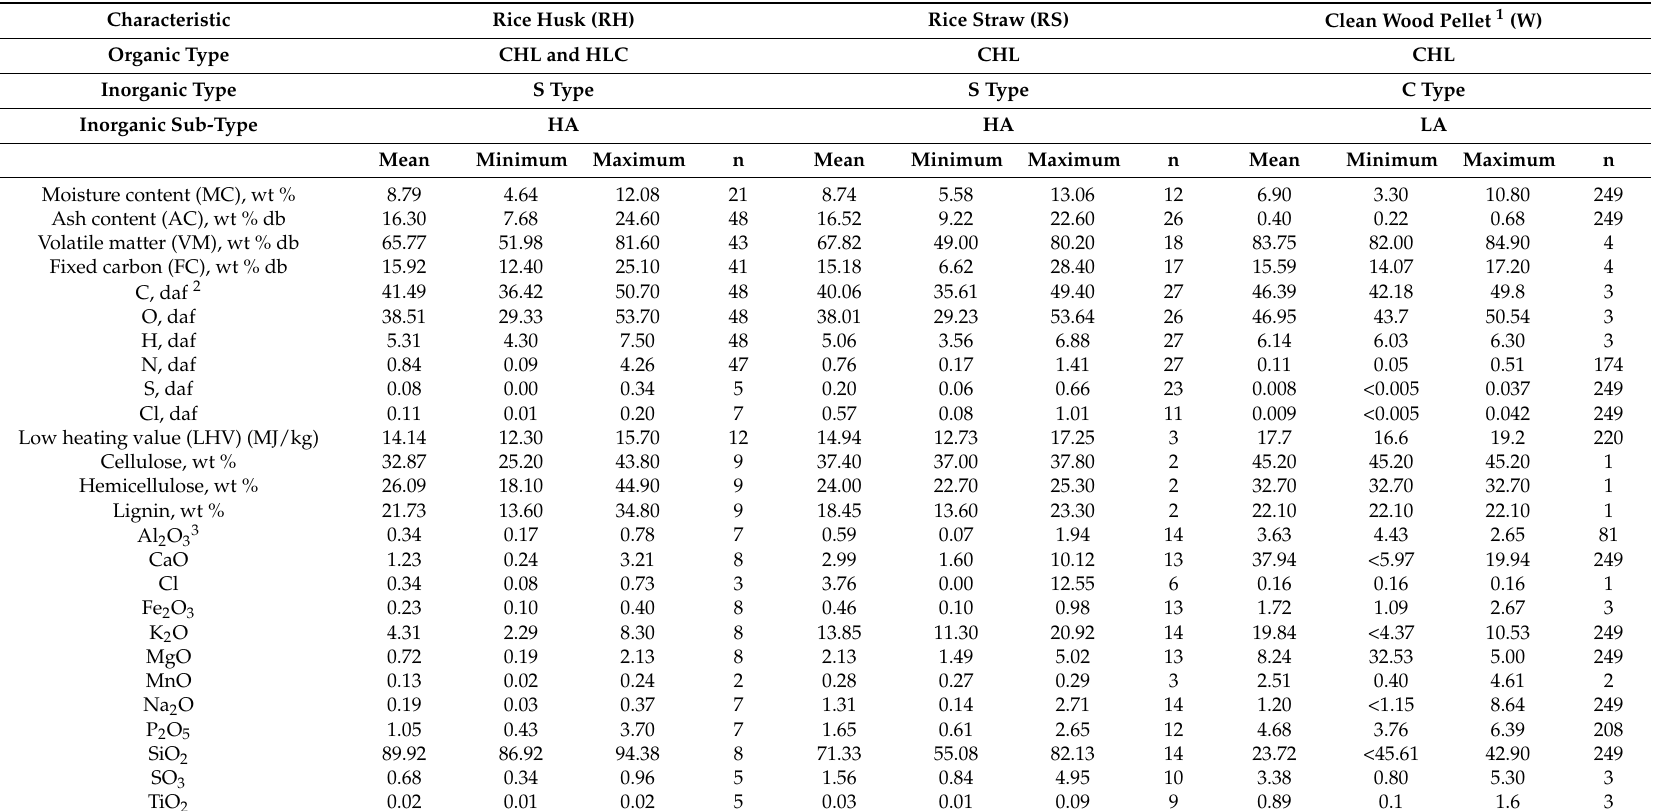
Table 1. Fuel properties of RH, RS, and wood (data were taken from [23,59,99,102,110–155] for RH, from [105,109,112,119–121,125,135,136,145,156–175] for RS and from [92,110,176–178] for wood; n: number of data